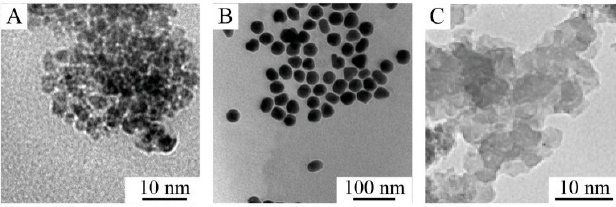
Figure 1. TEM images of nanoparticles (NPs). (A) Magnetite nanoparticles (MNPs). (B) GNPs-30. (C) Silica nanoparticles (SNPs).